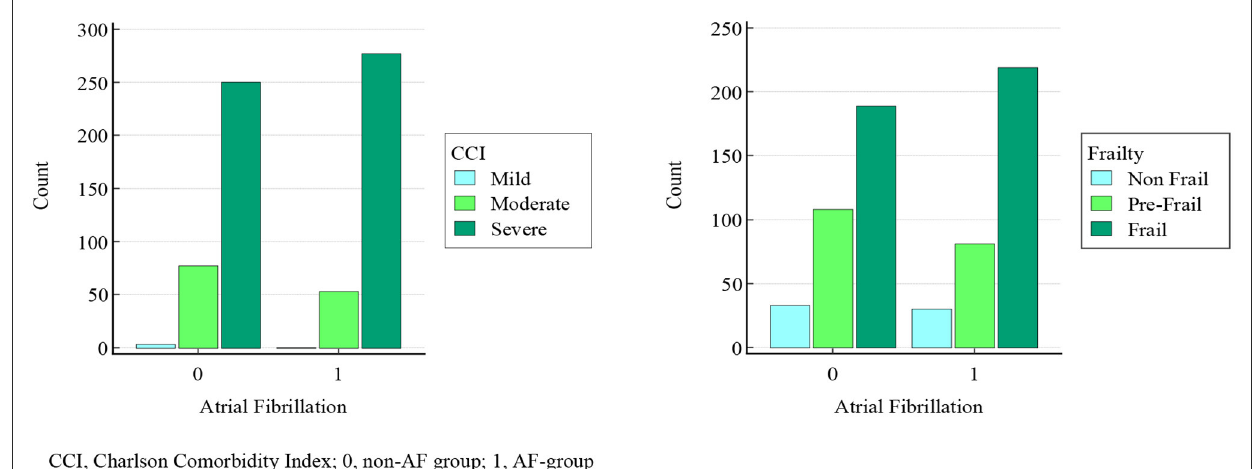
FIGURE3 Comparison of comorbidity burden and frailty status in AF and non-AF group. CCI, Charlson Comorbidity Index; 0, non-AF group; 1, AF-group.